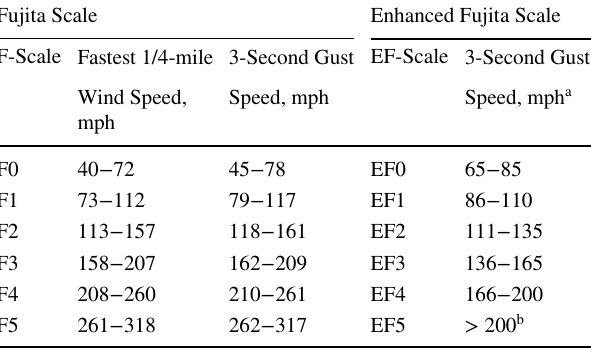
Table 1 Enhanced Fujita Scale (EF-Scale) wind speed ranges derived from Fujita scale wind speed ranges extracted from Mehta